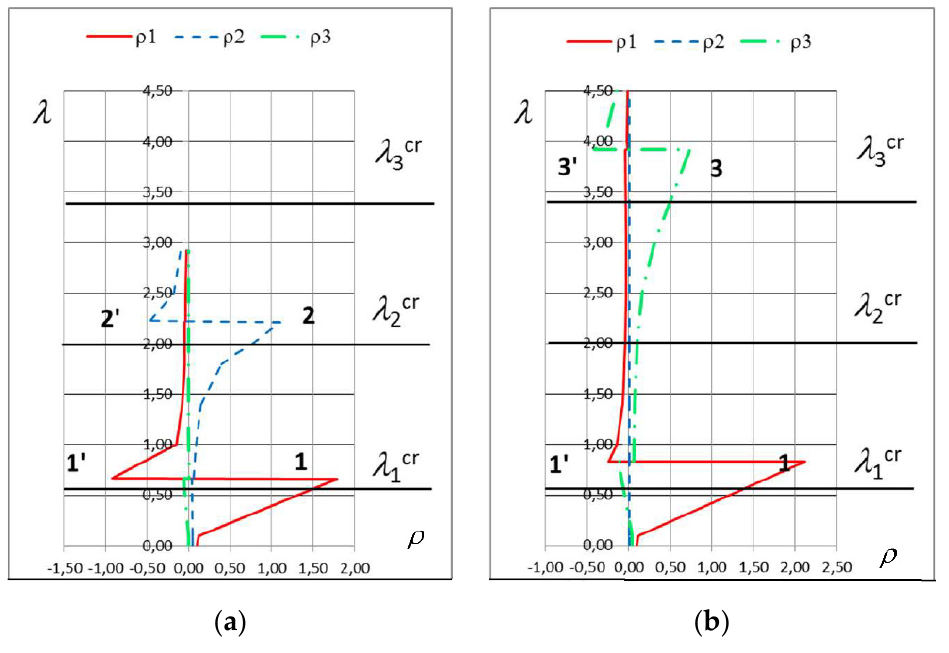
Figure 20. Coefficient ρ for geometrical imperfections: ( a ) d 1 s 2, ( b ) d 1 s 3.